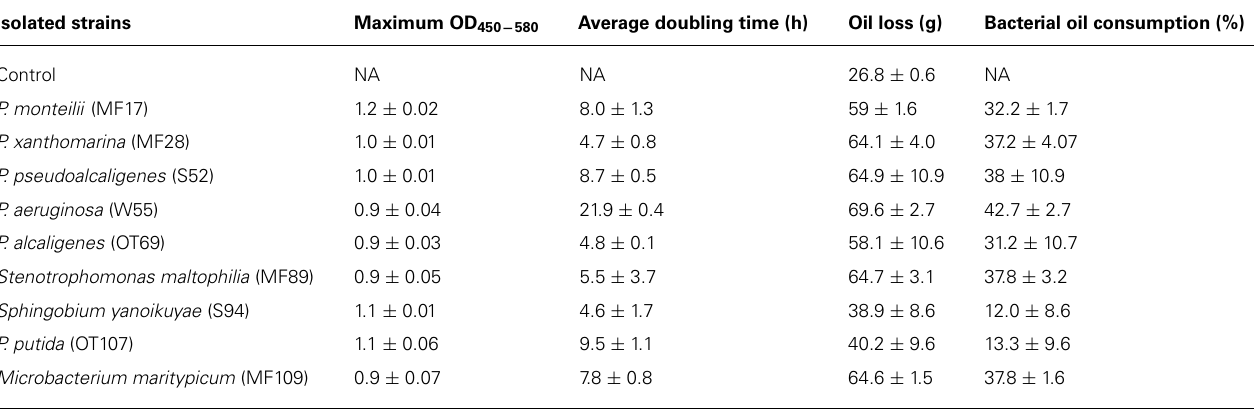
FIGURE 5 | Growth profiles of 10 selected isolated strains obtained from microcosms spiked with 0.75% DWH crude oil as the sole source of carbon and energy over the course of 7 days. Table 3 | Growth kinetics and oil degradation abilities of nine selected strains isolated from oyster tissue (OT), mantle fluid (MF), water column (WC), and sediment (S) samples obtained from Dry Bar,Apalachicola Bay, FL, USA. Isolated